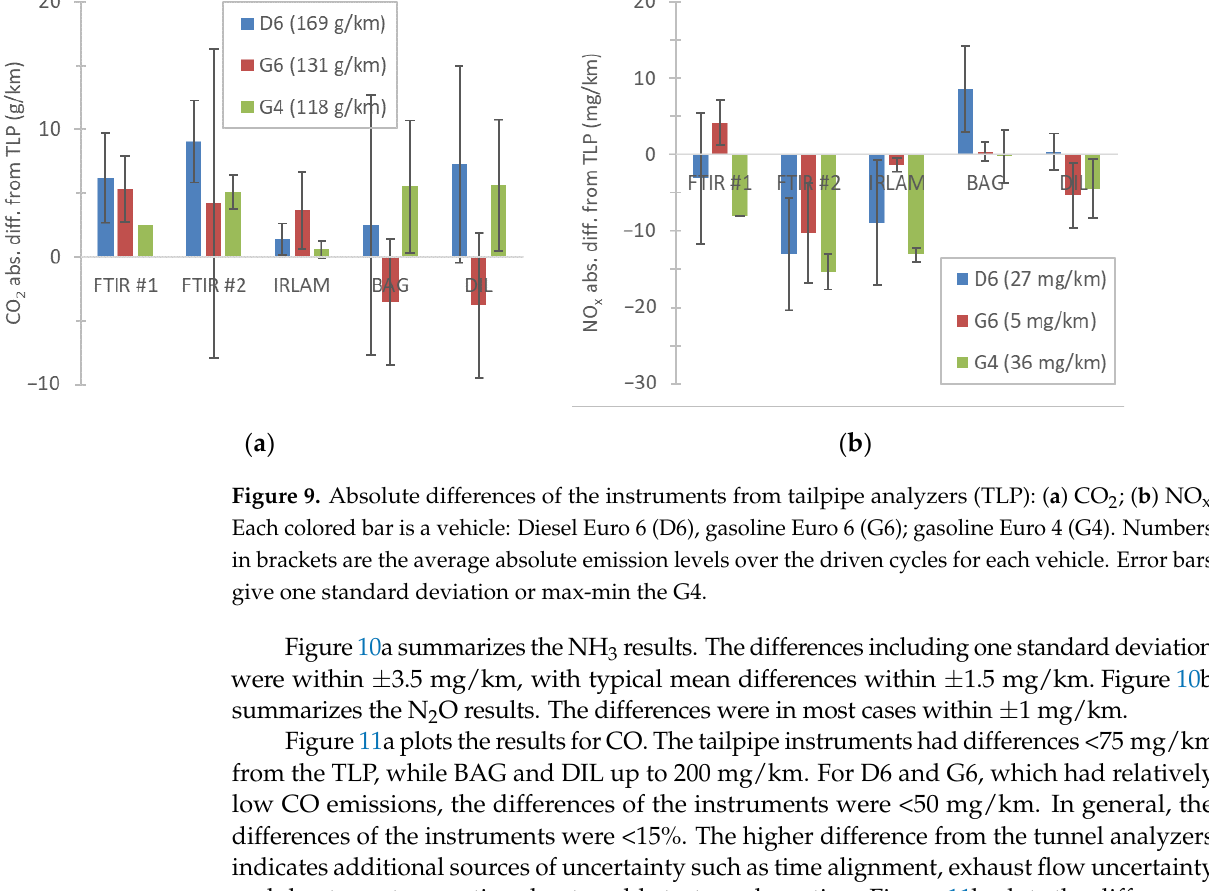
( b ) Figure 10. Absolute differences of the instruments from their mean: ( a ) NH 3 ; ( b ) N 2 O. Each colored bar is a vehicle: Diesel Euro 6 (D6), gasoline Euro 6 (G6); gasoline Euro 4 (G4). Numbers in brackets are the average absolute emission levels. Error bars give one standard deviation or max-min in the case of the G4.